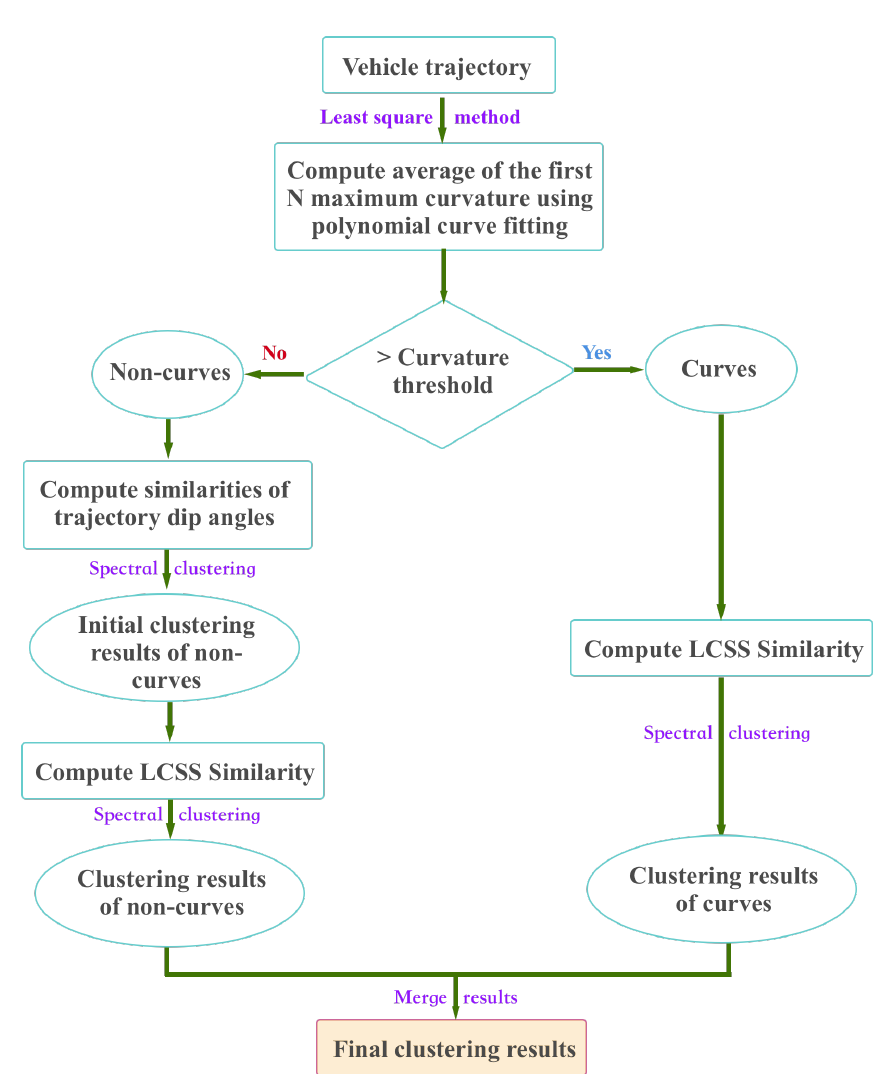
Figure 3. The working flow of the proposed double spectral clustering (DSC) method. For curve trajectories, we directly measure their pairwise similarities using the longest common sub-sequence similarity (LCSS) measure. For non-curve trajectories, we first cluster them according to the similarities of their dip angles, then use LCSS again to obtain the final results. Finally, we combine the clustering results on the two types of